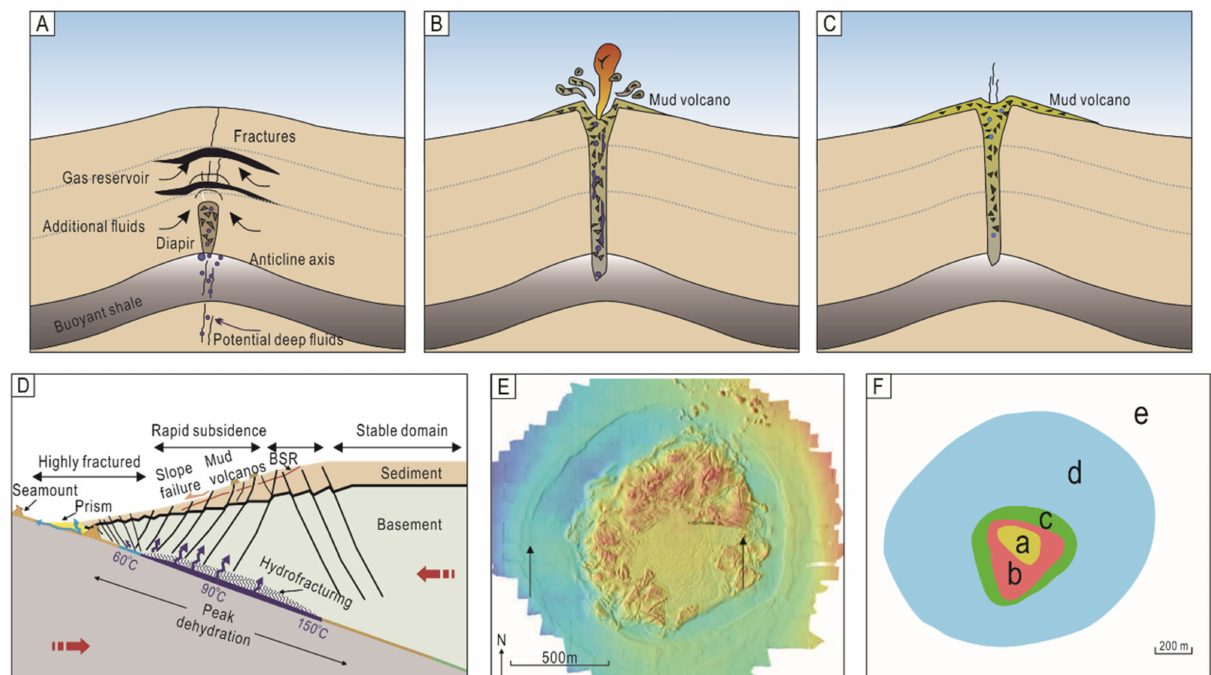
Figure 24. ( A – C ): Illustrations depicting the main growth stages of a mud volcano (MV) at a passive margin (modified from [136,139]). ( A ) Diapir roots in the buoyant shales with fluid migration along structural highs (e.g., anticlines, folds) or fault networks. Overpressurization increases due to the contribution of different fluids from adjacent sediment units. ( B ) Sudden pressure release allows a large amount of gas–fluid-rich mud breccia flow to erupt at the seafloor. ( C ) Remaining fluids continue to be released, accompanied by small eruptions. Most MVs are currently in this latter condition. ( D ) MV at convergent margin off Costa Rica. Muds and fluids are forced upward through deep-reaching fractures [138]. ( E ) A bathymetry map of the Håkon Mosby MV from 2003. The volcano is surrounded by a slight depression. The undulating areas shown on the map denote the hydrate field. ( F ) Map showing the variation of gas hydrate content in the sediment. No hydrate is recovered in zones “a” (crater) and “e” (margin). Hydrate contents vary from a few percent